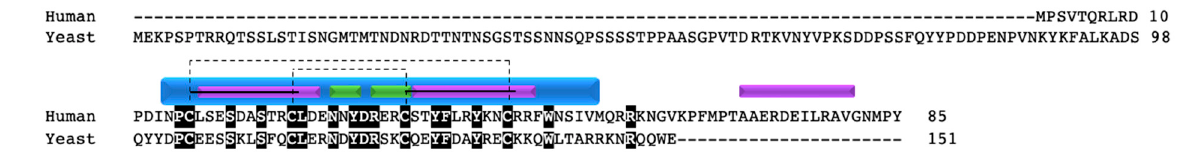
Figure 4. CHCHD7/Cox23p. Alignment of human and yeast CHCHD7/COX23 protein sequences. Black boxes indicate conserved residues. Human sequence annotation is as follows: Blue box indicates the CHCH domain. Purple boxes indicate a helix. Green boxes indicate a turn. Solid black lines indicate the twin CX 9 C motif. Dashed lines indicate the cysteine pairs that form structural disulfide bonds.